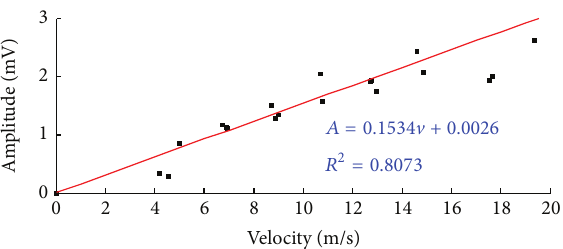
Figure 8 is a schematic diagram of the field test